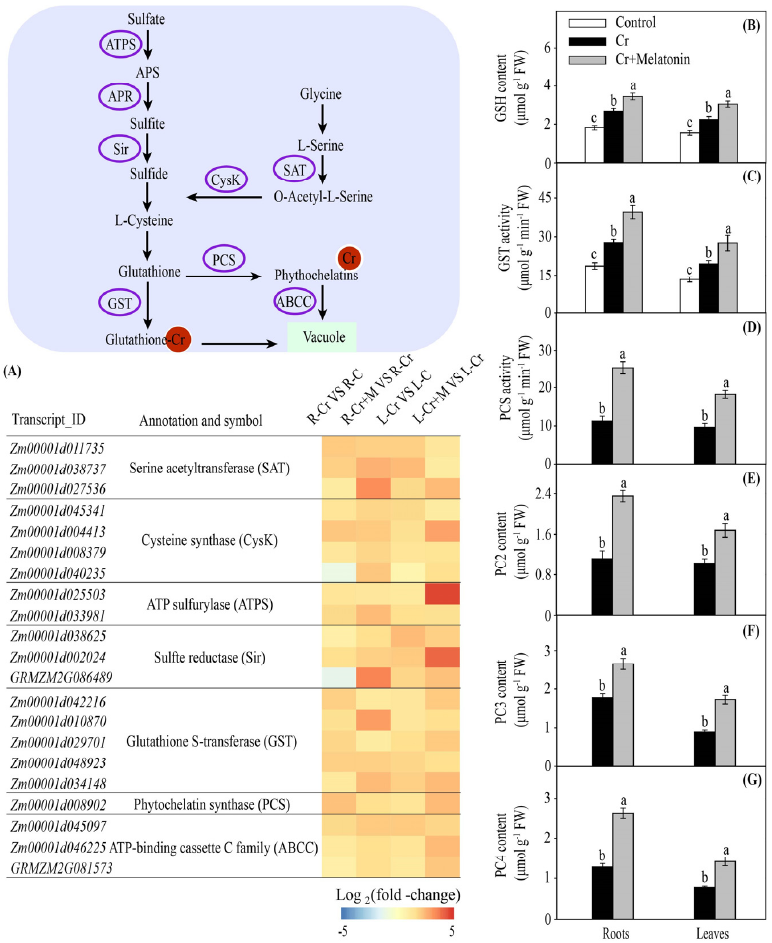
Figure 5. Melatonin and Cr induced changes in gene transcripts involved in glutathione (GSH) metabolism in maize roots and leaves ( A ). The color scale represents log 2 (fold-change). The effect of melatonin on glutathione (GSH) content ( B ), glutathione S-transferase (GST) activity ( C ), phy- tochelatin synthase (PCS) activity ( D ), and phytochelatins (PCs) contents ( E – G ) in maize roots and leaves under Cr stress. Different letters in one measure (roots or leaves) denote significant differences at p < 0.05. Data are shown as mean ± SE ( n =